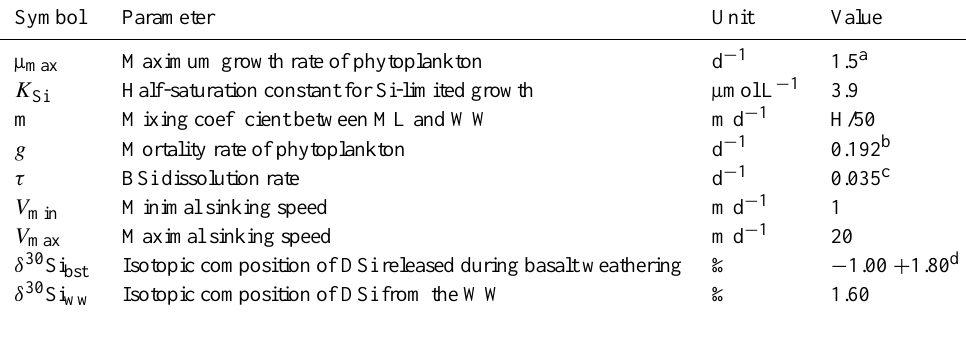
Table 3. Abbreviations and subscripts used in the model equations. Variables Abbreviation Units DSi winter